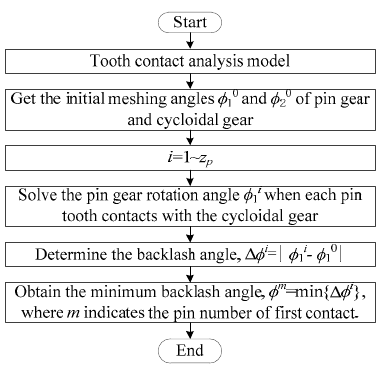
Figure 10. Process of solving the minimum backlash angle.